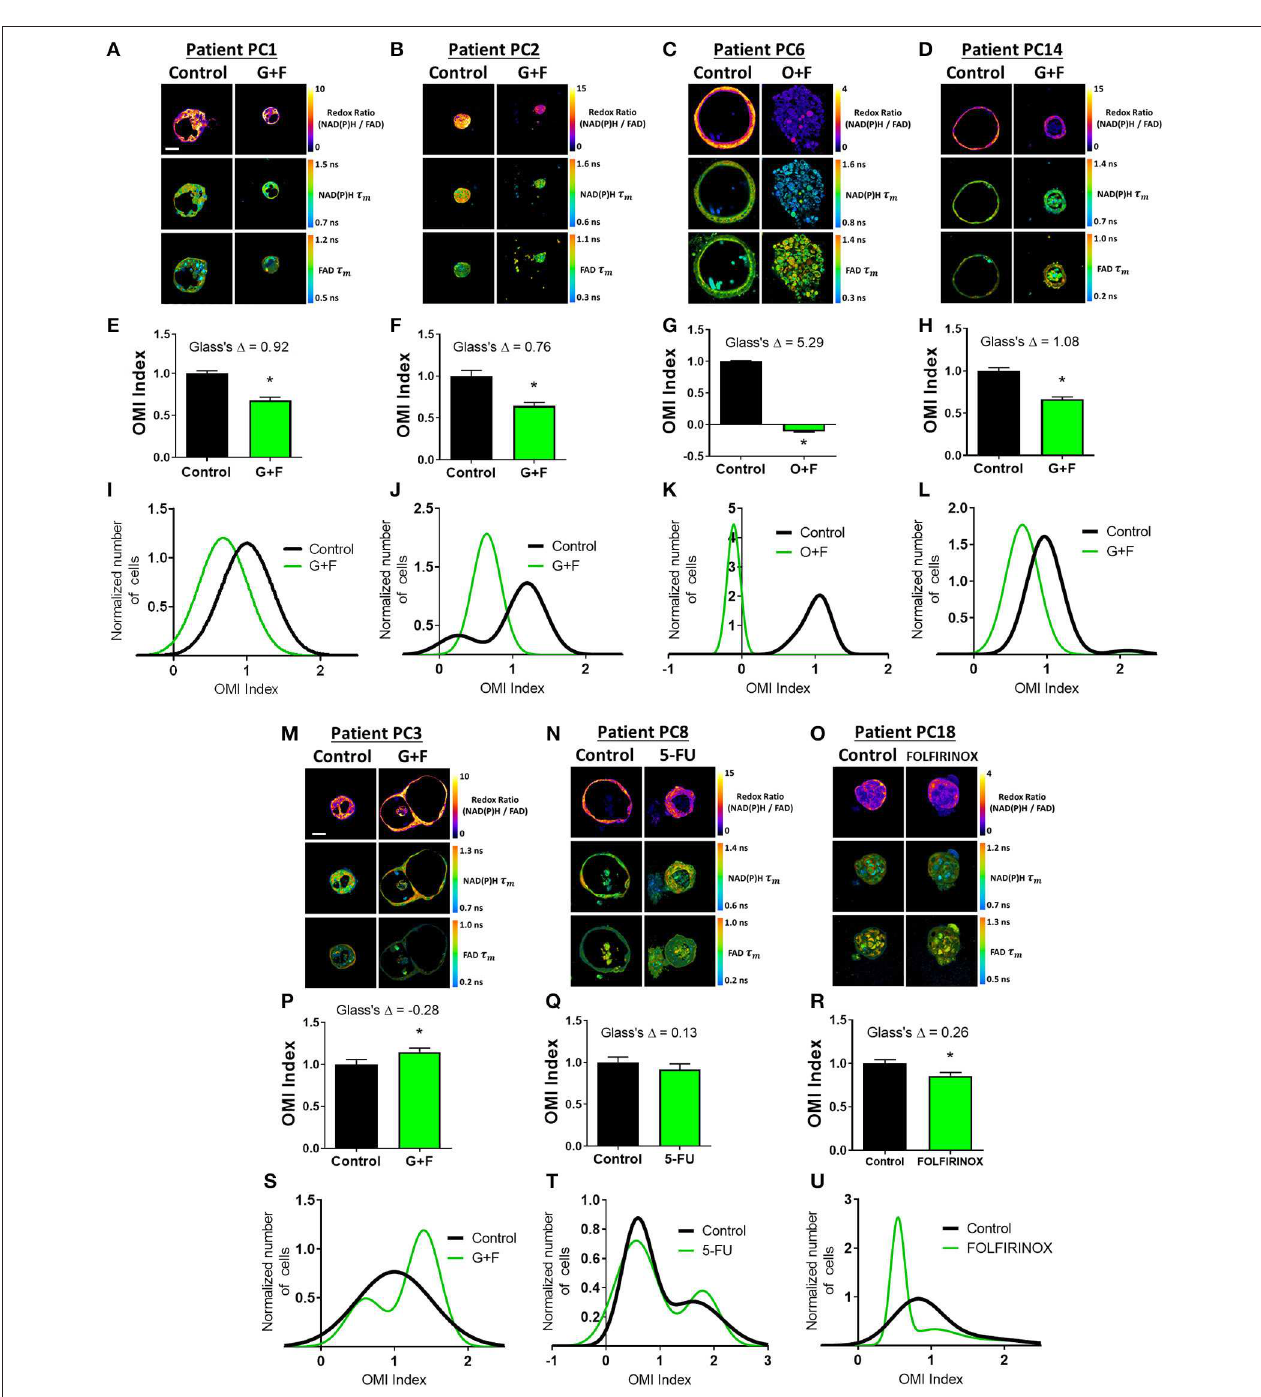
FIGURE 5 | Organoid-based predictions of pancreatic cancer patient response to therapy. (A–D) Representative redox ratio, NAD(P)H τ m , and FAD τ m images of pancreatic organoids from Patients PC1 (A) , PC2 (B) , PC6 (C) , and PC14 (D) , who are classified as predicted responders. Left columns indicate control organoids, and right columns indicate organoids treated with the same drugs as the patient adjuvant treatment. Scale bar is 50 µ m. (E–H) The effect of the same drugs on the OMI index averaged across all cells in organoids derived from Patient PC1 (E) , PC2 (F) , PC6 (G) , and PC14 (H) . Error bars indicate mean ± SEM. * p < 0.0001. (I–L) Single-cell OMI index subpopulation analysis of treatment response in organoids from Patient PCI (I), PC2 (J) , PC6 (K) , and PC14 (L) . (M–O) Representative redox ratio, NAD(P)H τ m , and FAD τ m images of pancreatic organoids from Patients PC3 (M) , PC8 (N) , and PC18 (O) , who are classified as predicted non-responders. Left columns indicate control organoids, and right columns indicate organoids treated with the same drugs as the patient adjuvant treatment. (P–R) The effect of the same drugs on the OMI index averaged across all cells in organoids derived from Patient PC3 (P) , PC8 (Q) , and PC18 (R) . (S–U) Single-cell OMI index subpopulation analysis of treatment response in organoids from Patient PC3 (S) , PC8 (T) , and PC18 (U) .